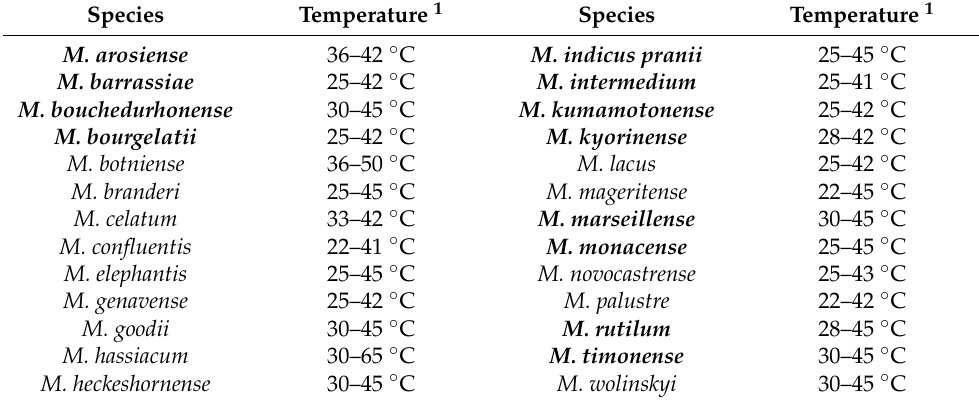
Table 3. Thermophilic nontuberculous mycobacteria. Species Temperature 1 Species Temperature